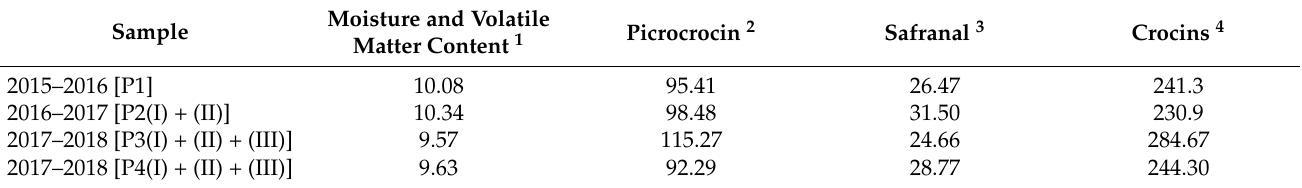
Table 4. Qualitative analysis of the saffron investigated.